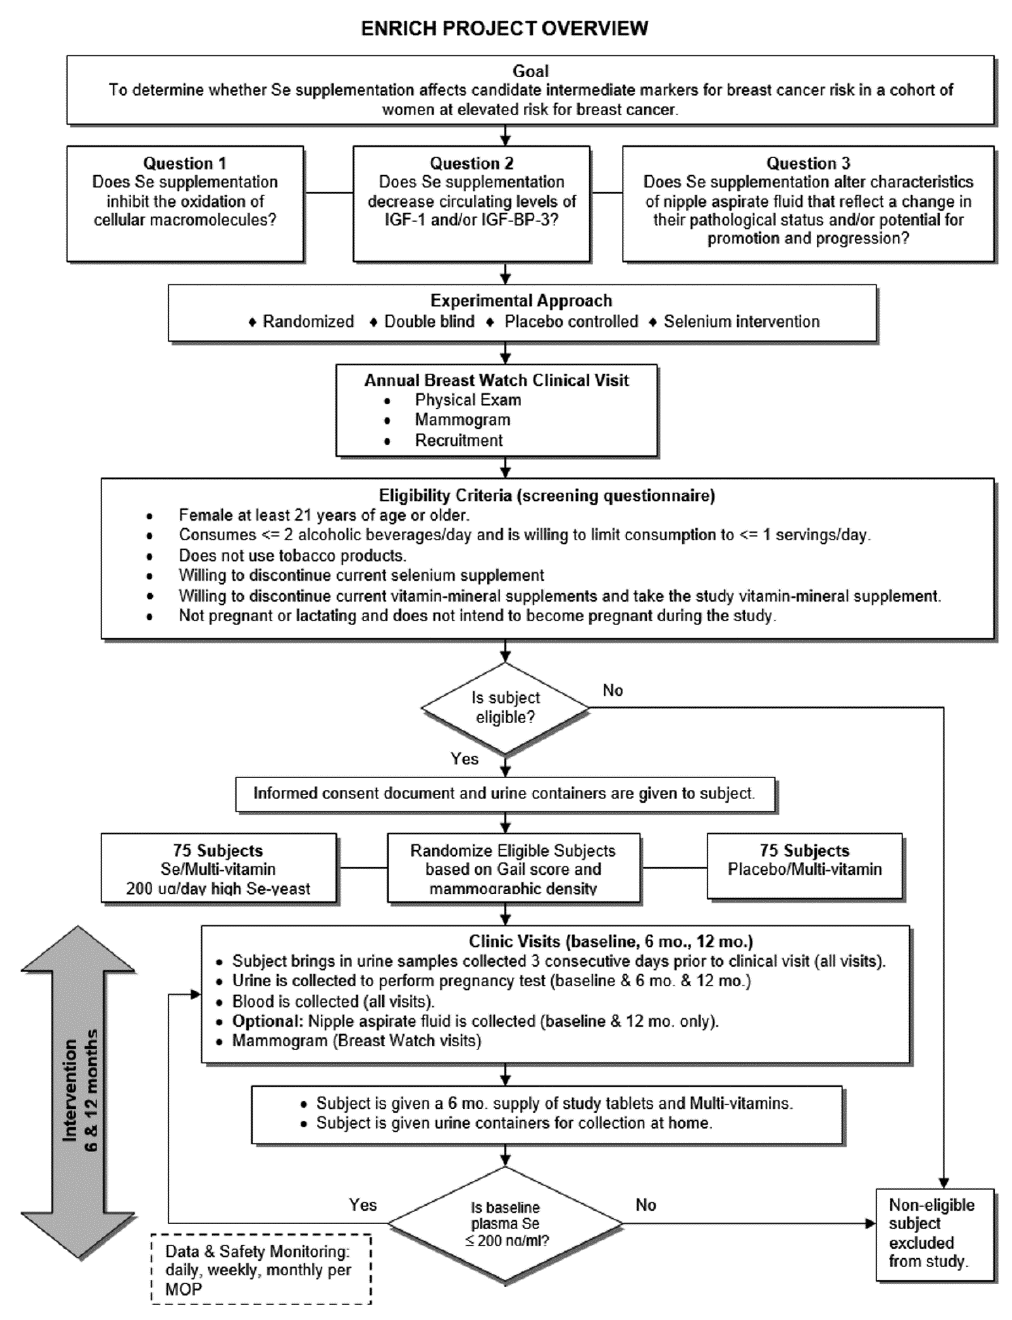
Figure 1. Study Design.